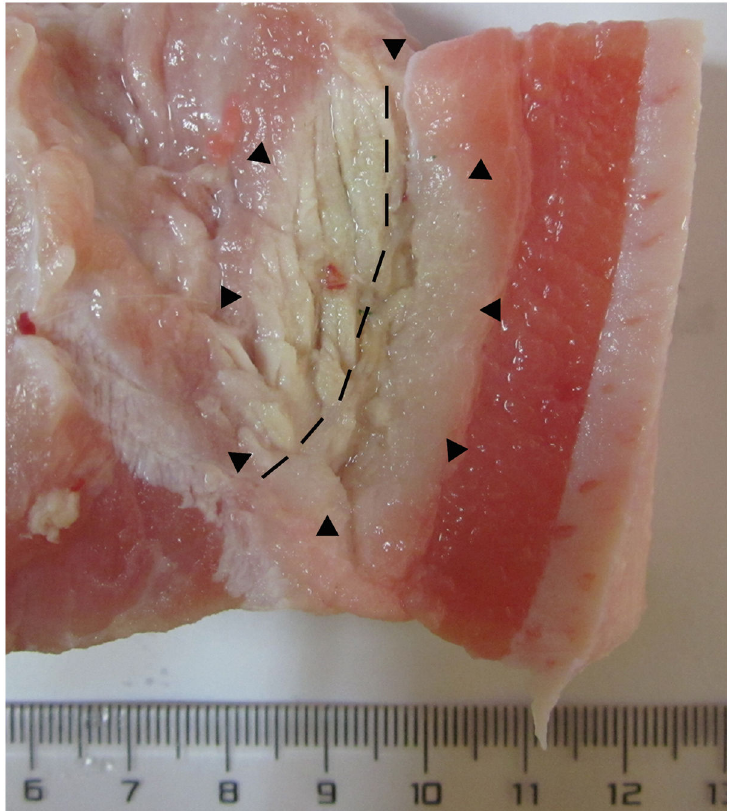
Figure 4. The coagulation zone (white zone) in the tissue containing both muscle (left) and adipose tissue (right) after 2,3,5-triphenyl tetrazolium chloride stain at 80 W for 3 minutes. The dashed line was the borderline between the muscle and adipose tissue.